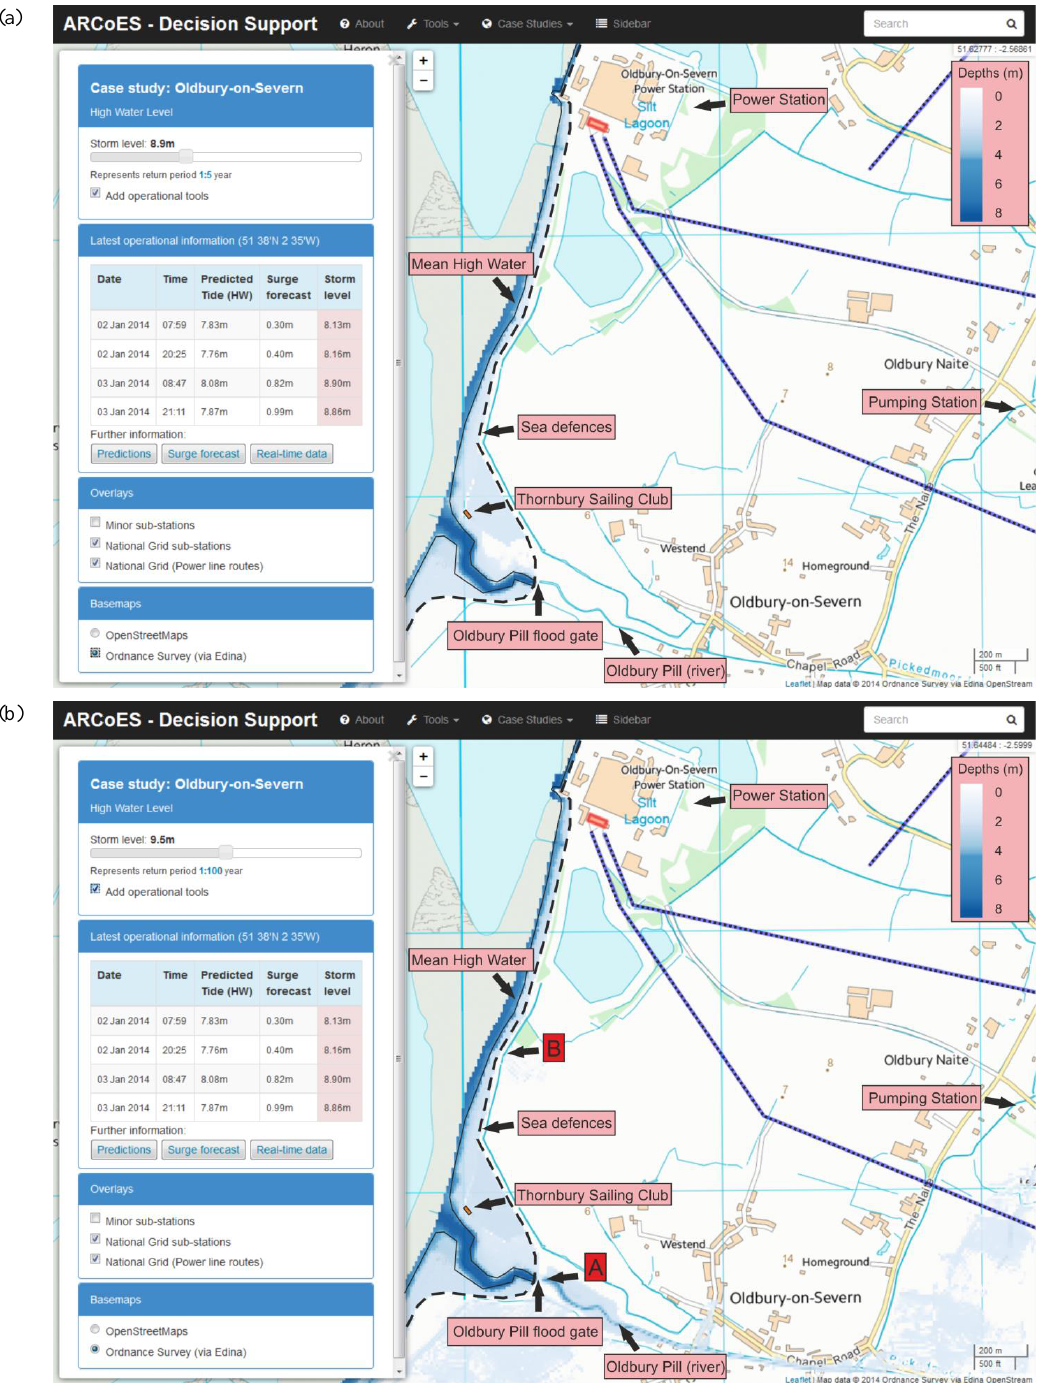
Figure 3. (a) DST screen shot of the scenario with a 8.9m storm level (extreme water level) (surge forecast of the 3 January 2014 storm used as a guide). Sea defences (black dashed line), sub-stations (red boxes), and power routes (black dashed lines with blue background) are overlain. No flooding occurs behind the sea defences. Flooding extent: around the Thornbury Sailing Club site. Note: labels with dark-pink backgrounds have been added to screen shot. (b) DST screen shot of the “ what-if scenario ” with a 9.5m storm level (extreme water level). Sea defences (black dashed line), sub-stations (red boxes), and power routes (black dashed lines with blue background) are overlain. Note: labels with dark-pink and red backgrounds have been added to screen shot. Labels A and B represent locations of over-washing. Flooding extent: main flooding via Oldbury Pill with minor flooding behind sea defences at (B). (c) DST screen shot of the sidebar components (see Fig. 3b for full screen shot including map): slider bar, operational tools, overlays, and base maps.